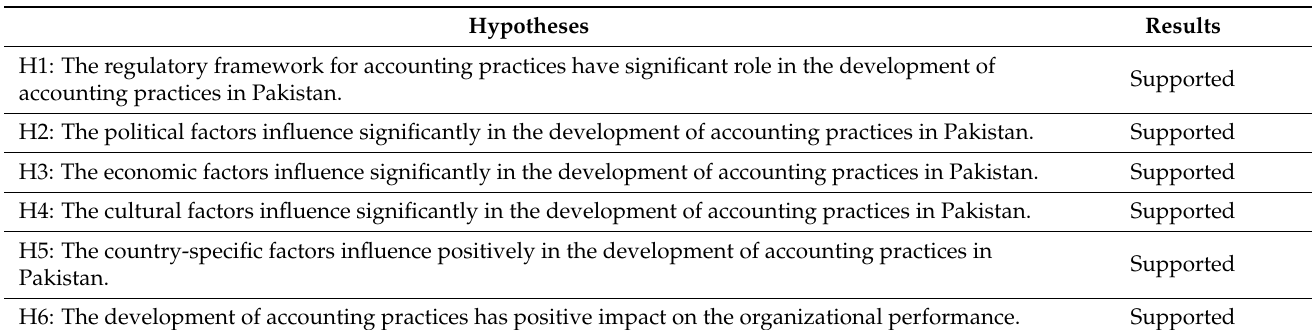
Table 10. Summary of Hypotheses